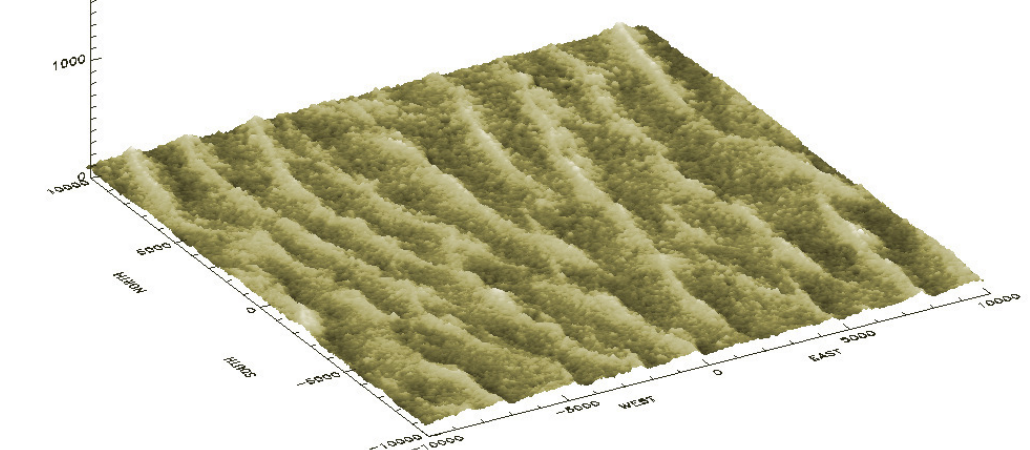
Figure 5. 3D scene of Libya-4 based on the ASTER DEM. The 20 × 20 km ROI shown here is centered on 28.55 ◦ N and 23.39 ◦ W. Distances are given in